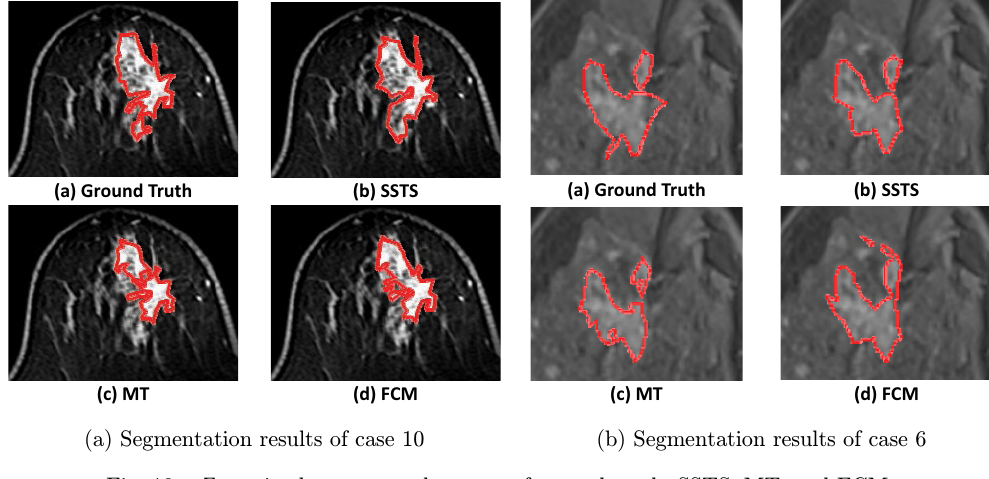
Fig. 10. Zoom in the segmented tumors of ground truth, SSTS, MT, and